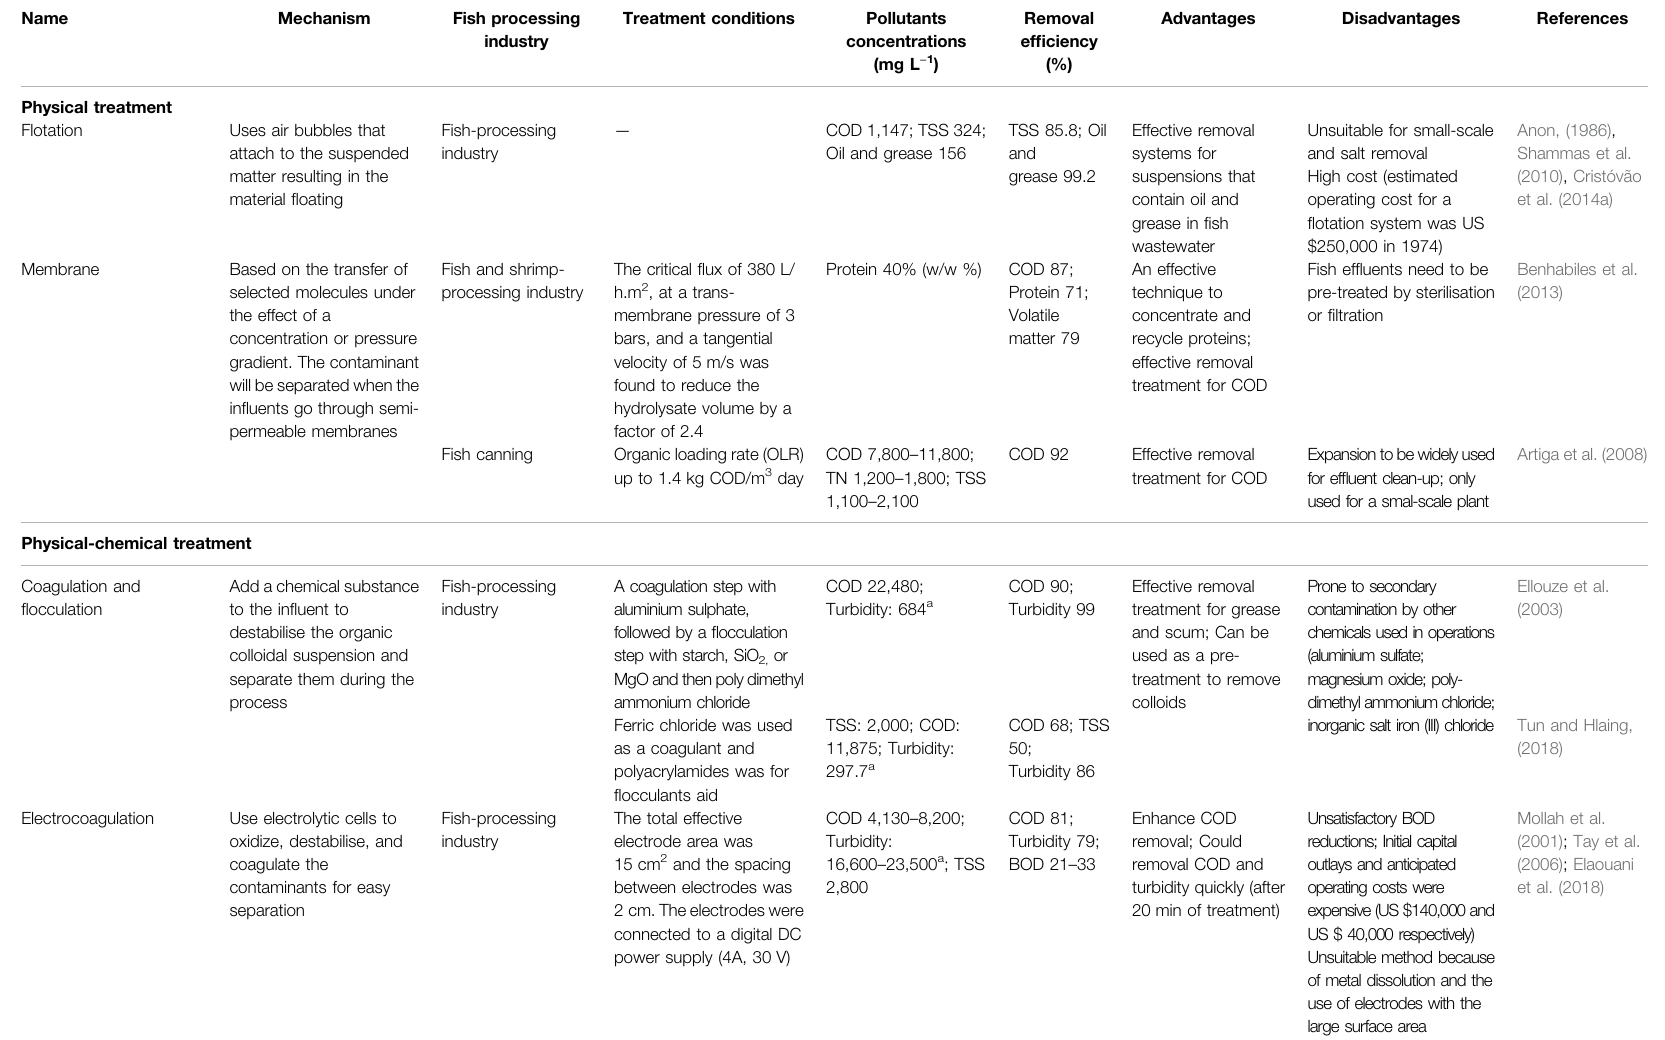
TABLE 2 | The advantages and disadvantages of current fi sh wastewater treatment